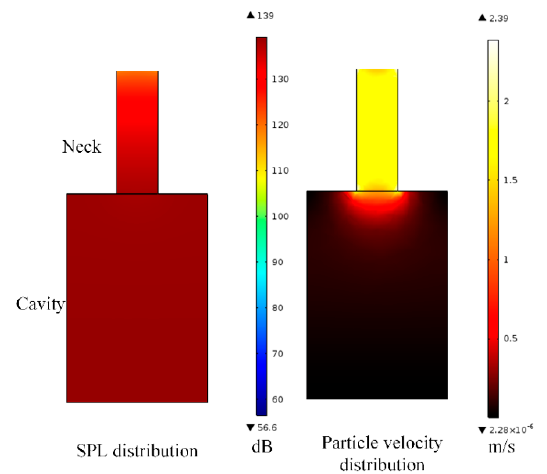
Figure 3. Sound pressure and velocity distribution of a Helmholtz resonator at the resonant frequency.